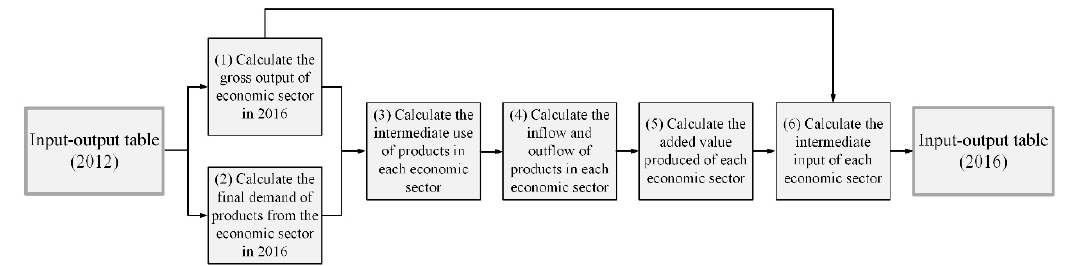
Figure 2. The updated path of the input-output table in the NTM region based on the RAS method.